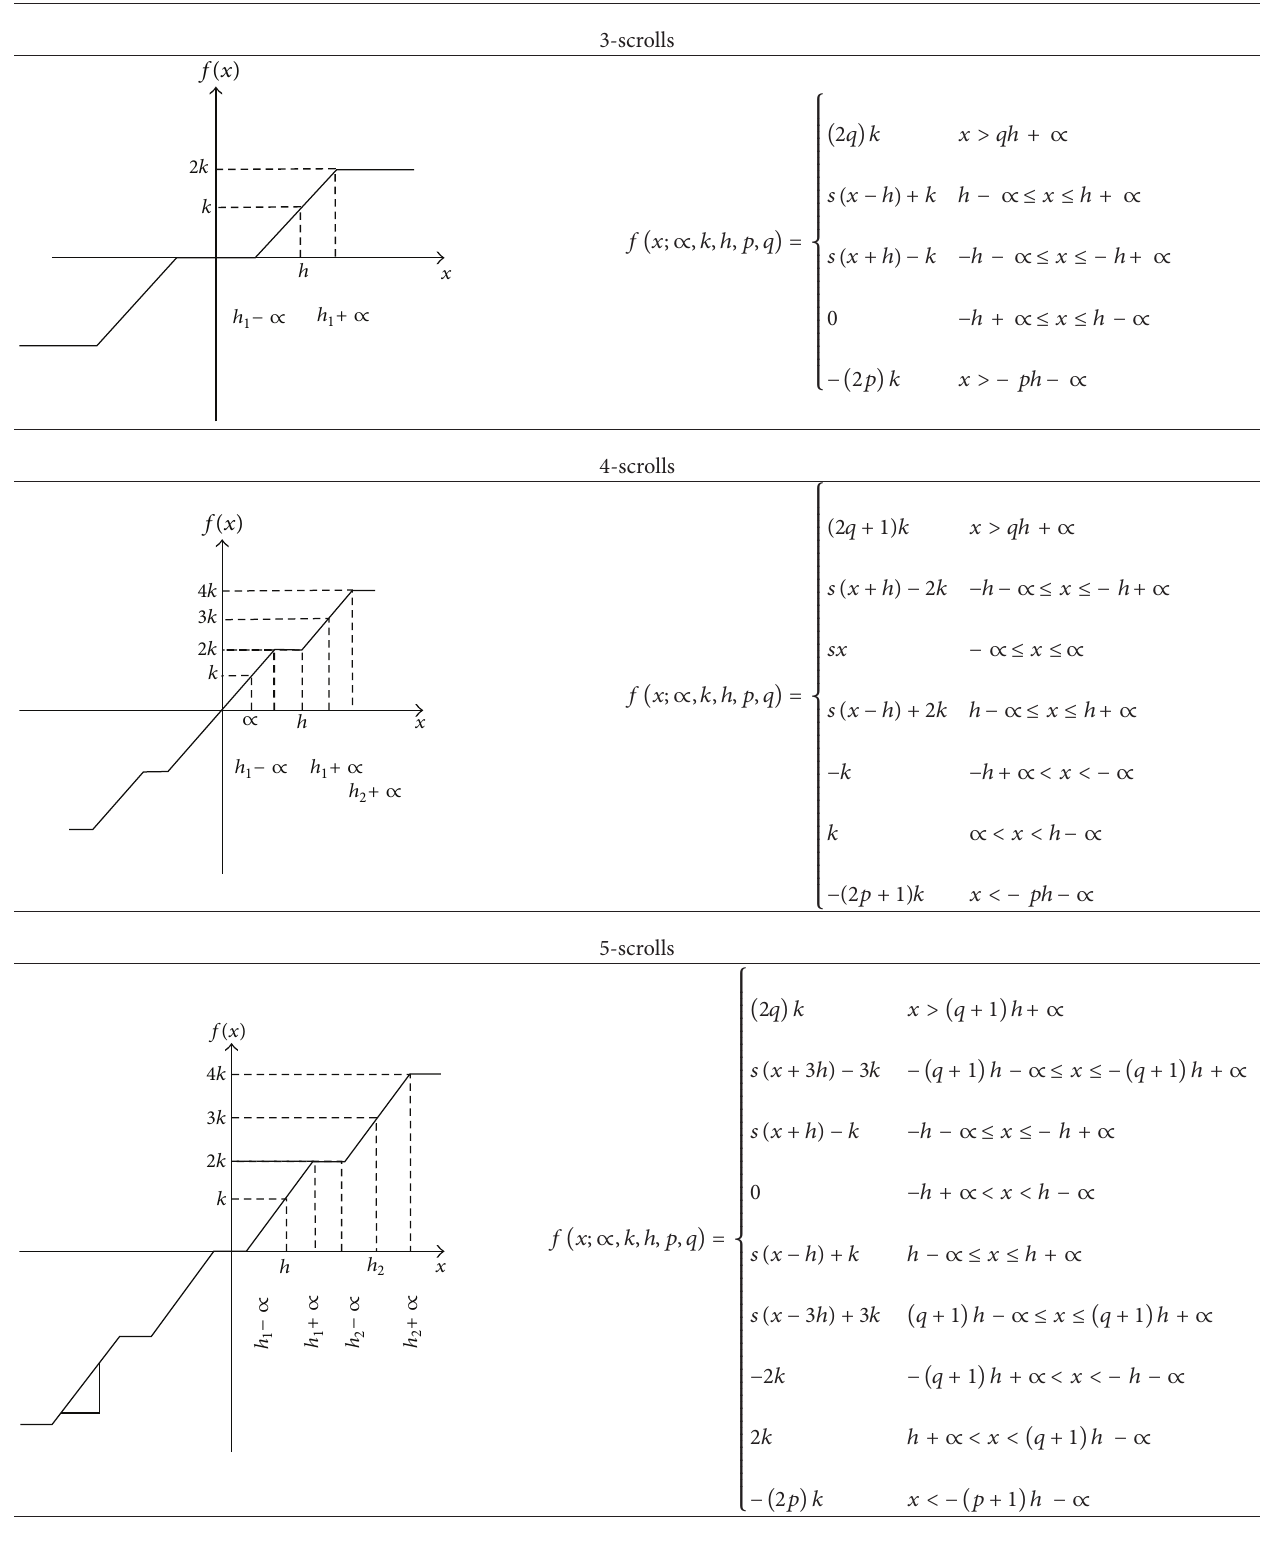
Table 1: Description of the SNLF for generating from 3 to 6